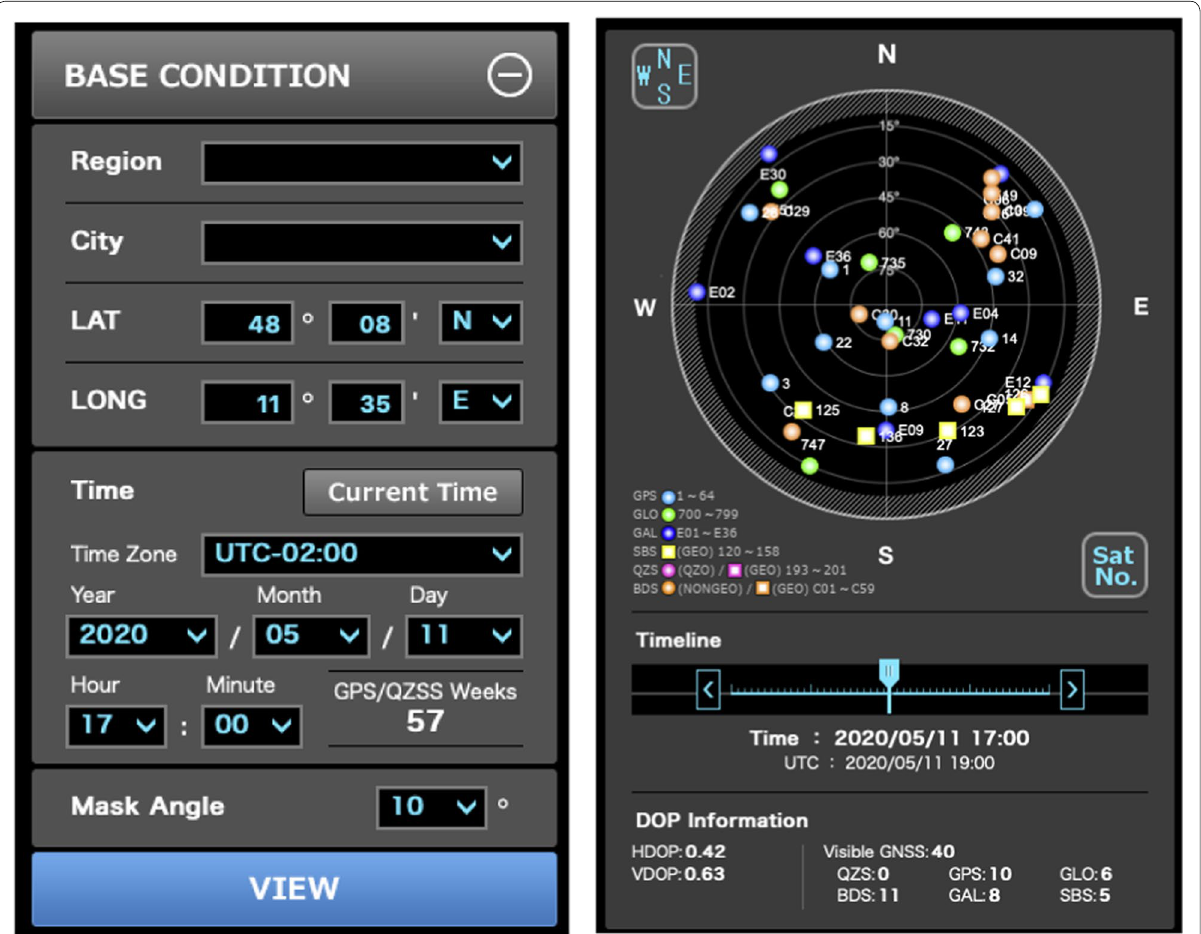
Fig. 1 GNSS Satellites in View in Munich on 11 May 2020. Reference: https ://qzss.go.jp/en/techn ical/gnssv iew/index